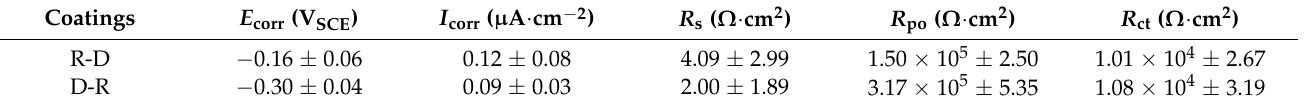
Table 1. Electrochemical fitted parameters determined by potentiodynamic polarization curves and Nyquist plots.